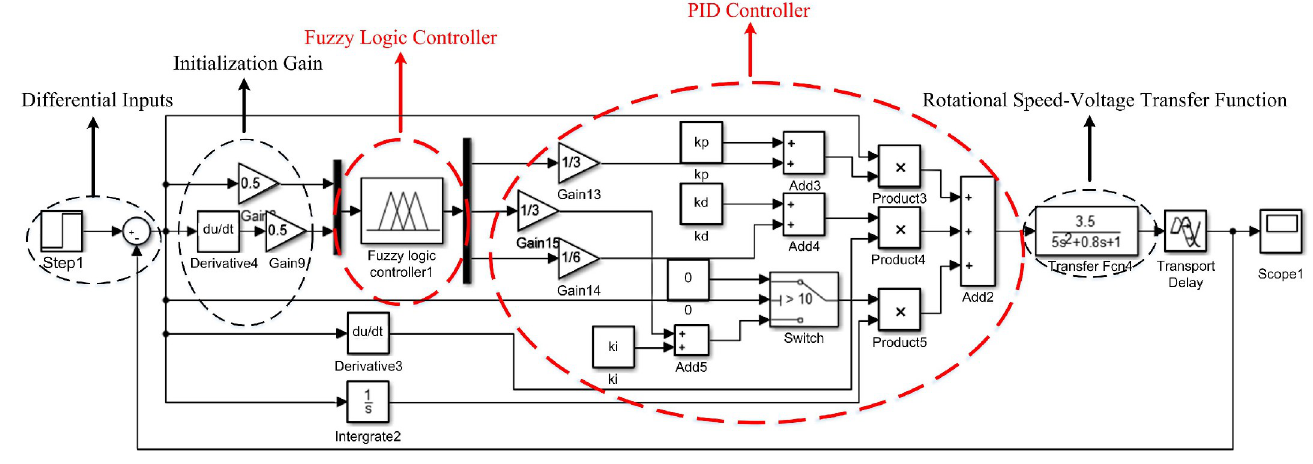
Fig 11. Fuzzy PID correction simulation